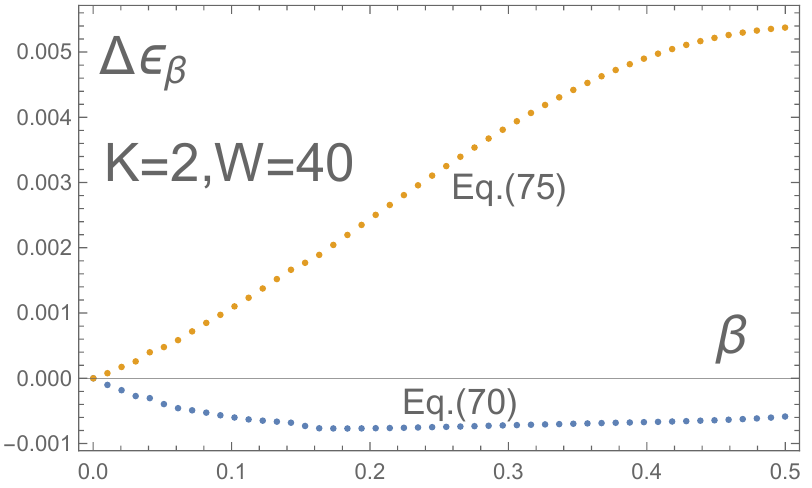
Figure 4: Comparison of the accuracy of approximation for ε β by Eq. (70) and by Eq. (75) . ∆ ε β is the difference between the numerical solution for ε β of the exact Eqs. (12), (14) and the approximate solutions for ε β , Eq. (70) and (75), as a function of β at W = 40 for a K = 2 Cayley